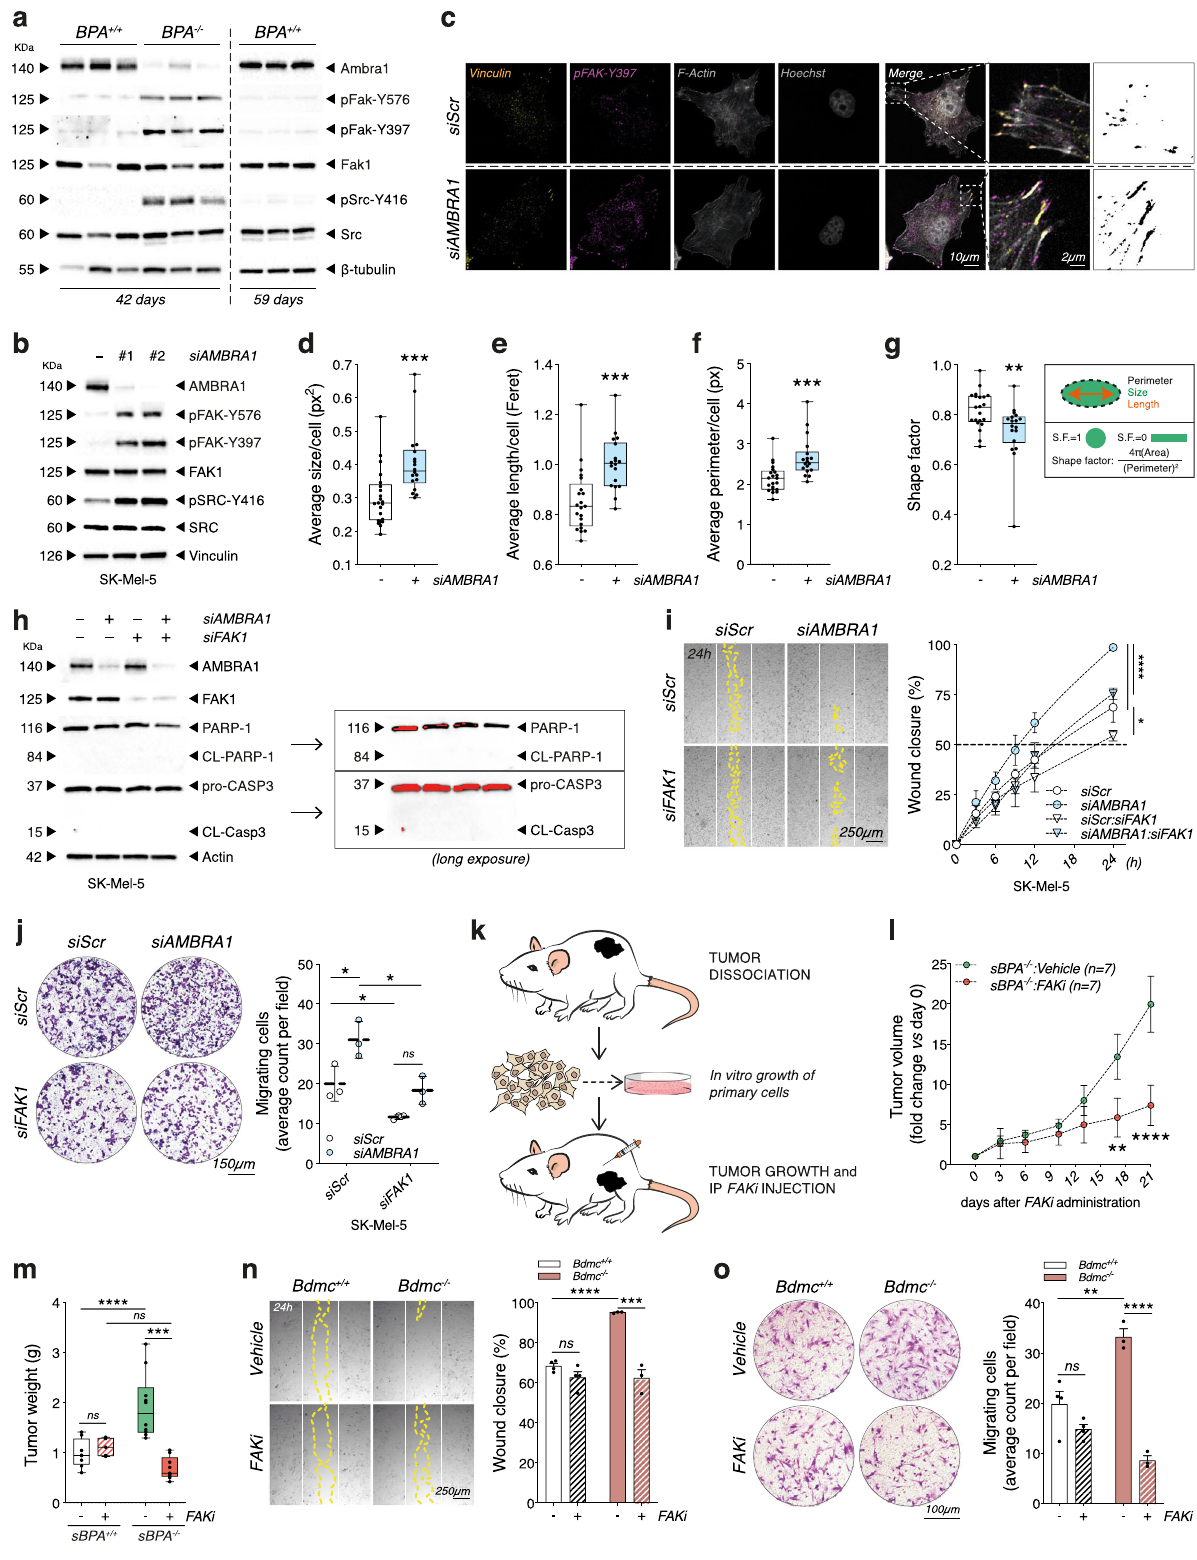
relevance of the AMBRA1-FAK1 interaction in determining the invasive ability of melanoma cells in our